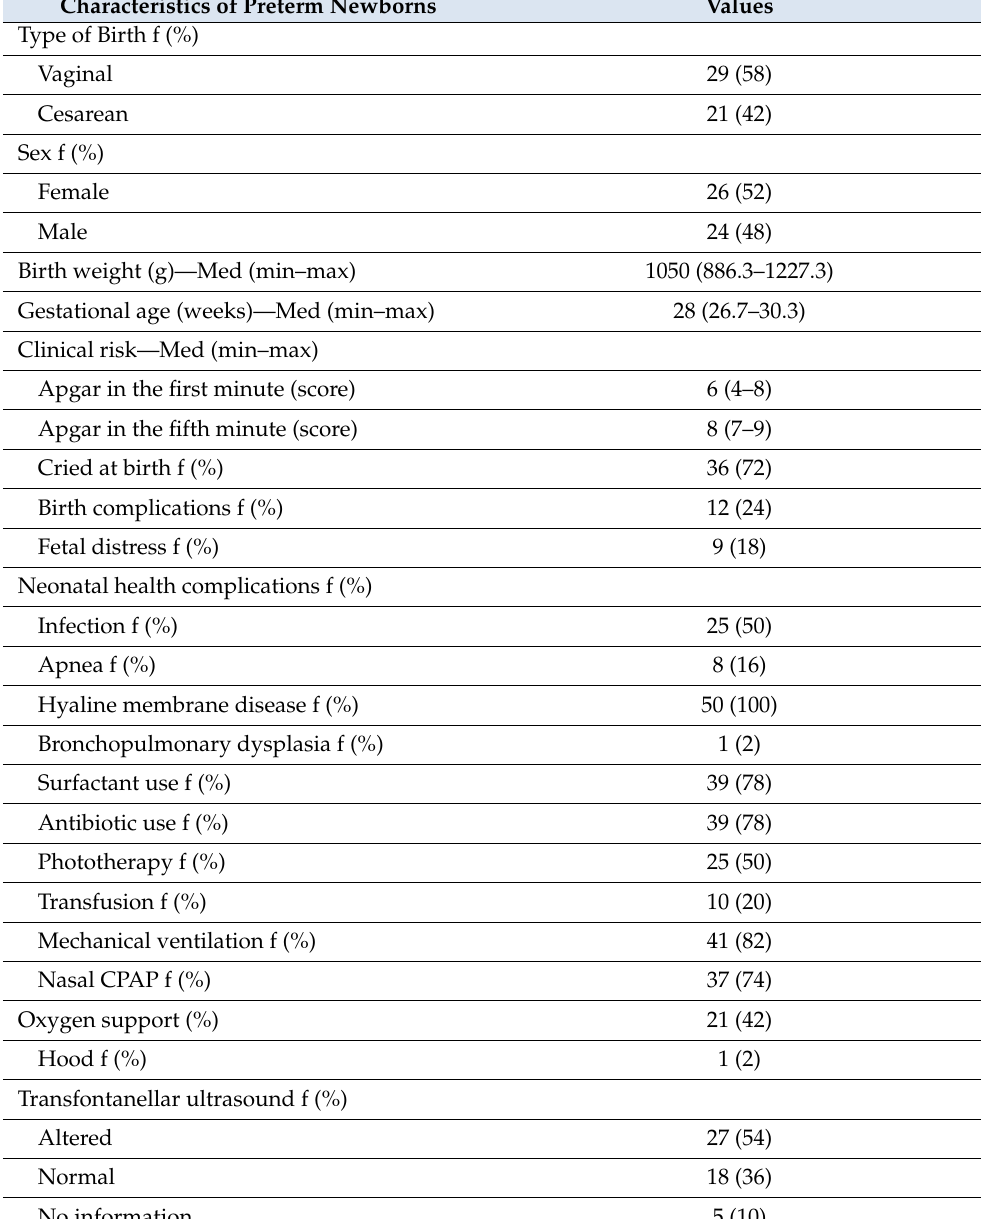
Table 1. Characteristics of the sample (n =